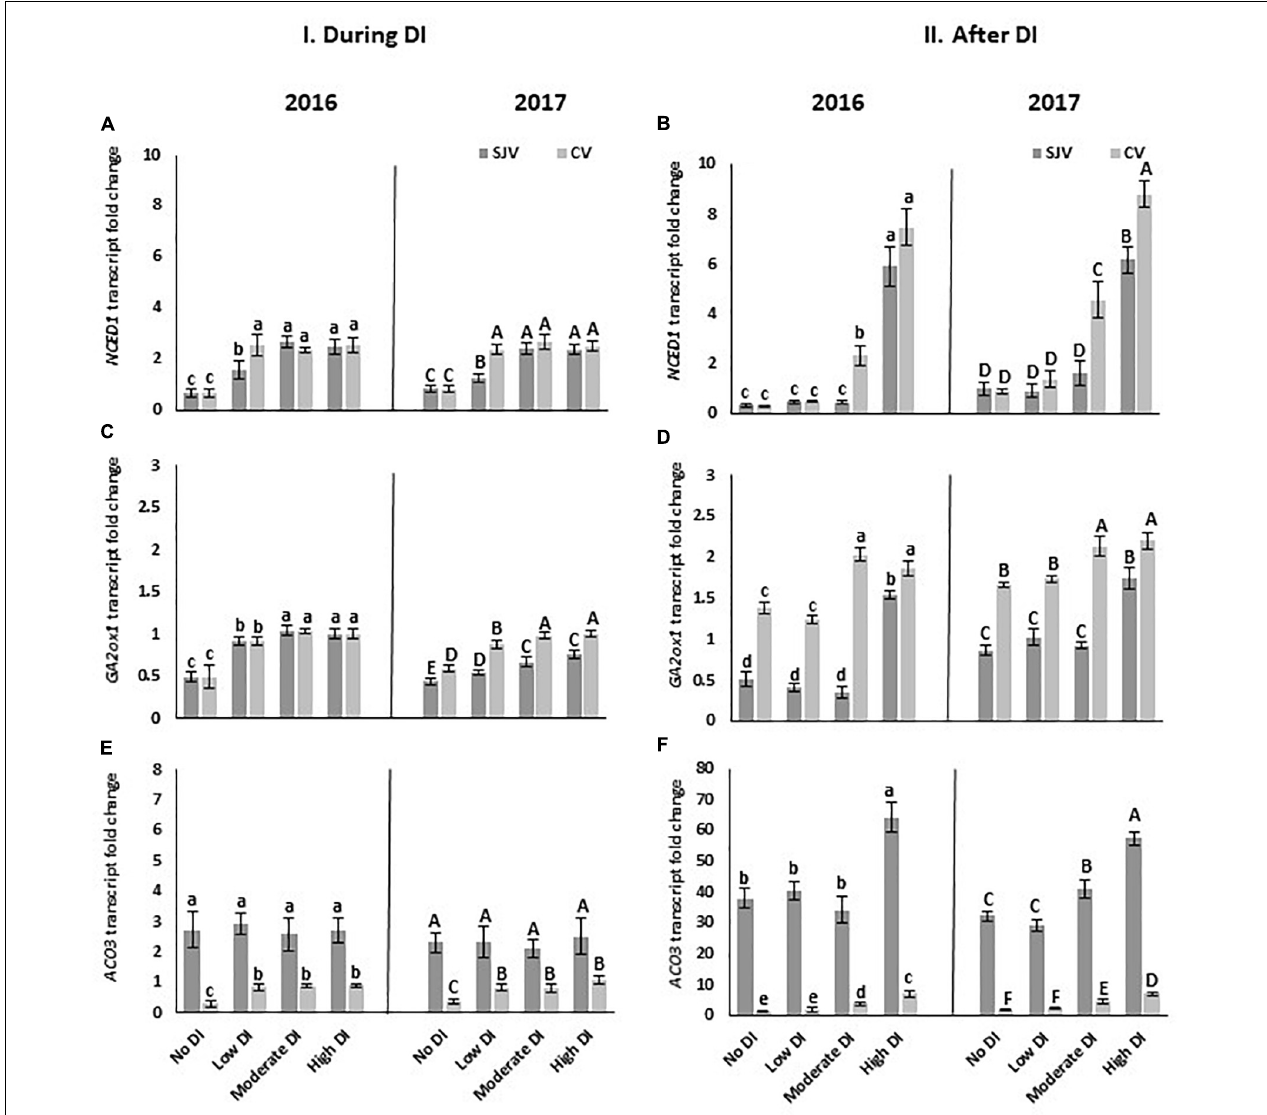
FIGURE 7 | Expression of genes involved in hormonal biosynthesis pathway in Scarlet Royal berry skin as affected by deficit irrigation (DI) treatments in 2016 and 2017 in San Joaquin (SJV) and Coachella (CV) Valleys. Genes involved in the hormonal biosynthesis are: abscisic acid (ABA) biosynthesis gene, 9-cis-epoxycarotenoid dioxygenase ( NCED1 ) (A,B) , gibberellic acid (GA) catabolic gene GA2 oxidase ( GA2ox1 ) (C,D) , and 1-aminocyclopropane-1-carboxylic acid oxidase ( ACO3 ) (E,F) . Gene expression was calculated during deficit treatment (I. During DI) and after re-irrigating vines with the original schedule (II. After DI). The error bars represent the standard deviation. Different letters on bars indicate significant differences among treatments and locations at p < 0.05 according to the Tukey HSD test within the same season. Different lower-case letters indicate a significant difference among treatments and locations in 2016 while capital letters are used for